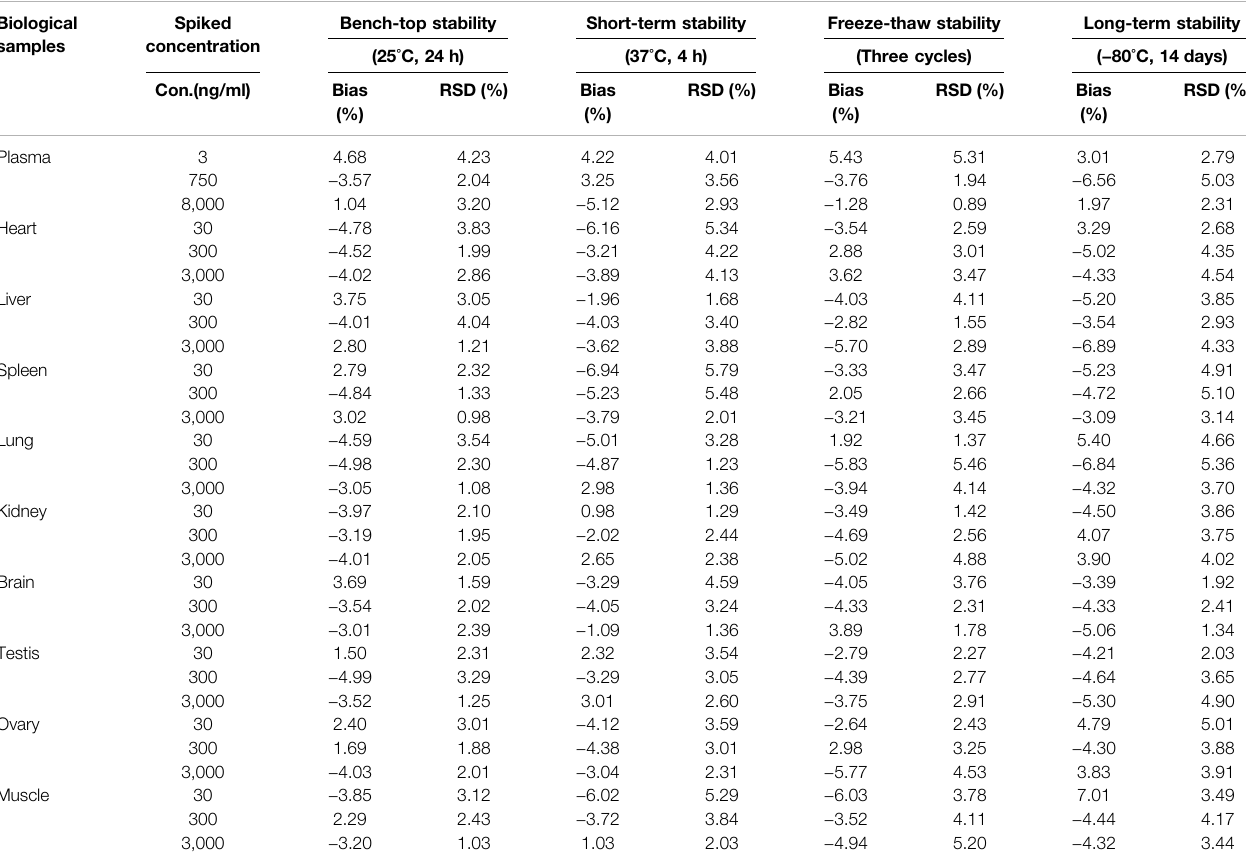
TABLE 3 | The stability of DF in rat plasma and tissues homogenate under different storage condition ( n (cid:1) 5). Biological Spiked samples